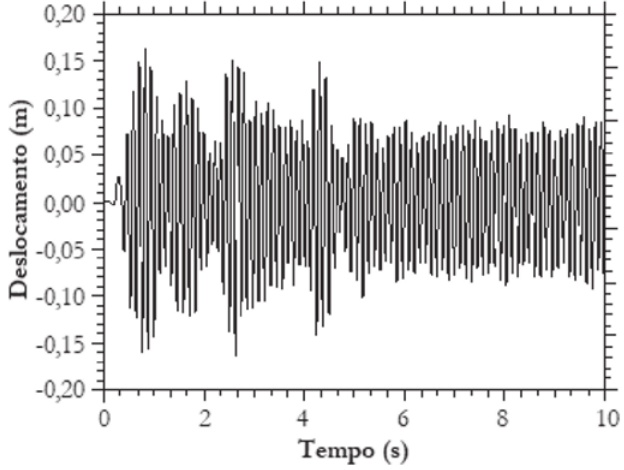
FFT para o deslocamento do vértice superior